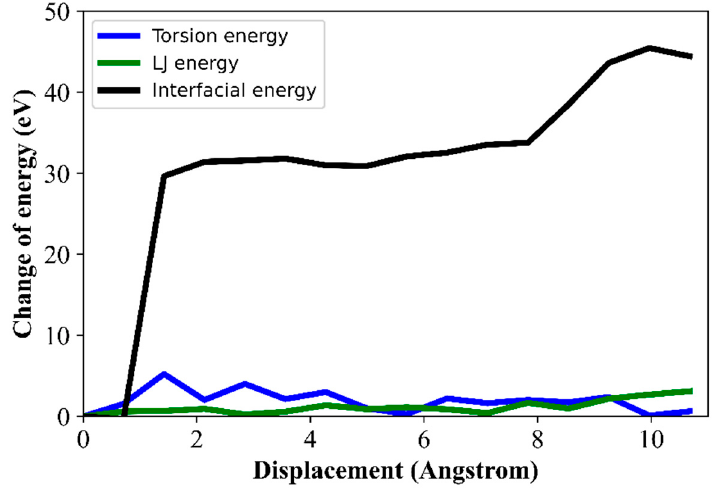
Figure 5. Change of the potential energy as a function of the displacement of nano-engineered carbon fiber-B4 with 3 wt% (8,6) 2.5 nm in length and 0.95 nm in diameter single-walled carbon nanotubes from twenty atactic 40-monomer polypropylene chains in the z -direction.